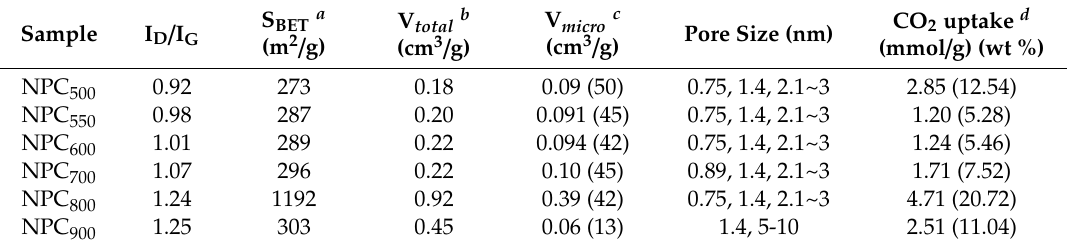
Table 1. Surface and porous properties of the NPC samples.